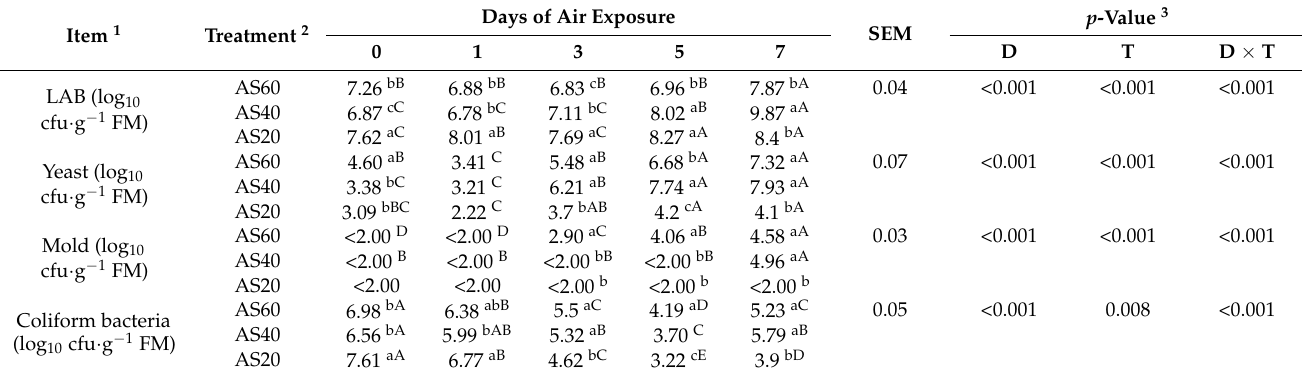
Table 6. Changes in microbial compositions of the TMR silages after exposure to